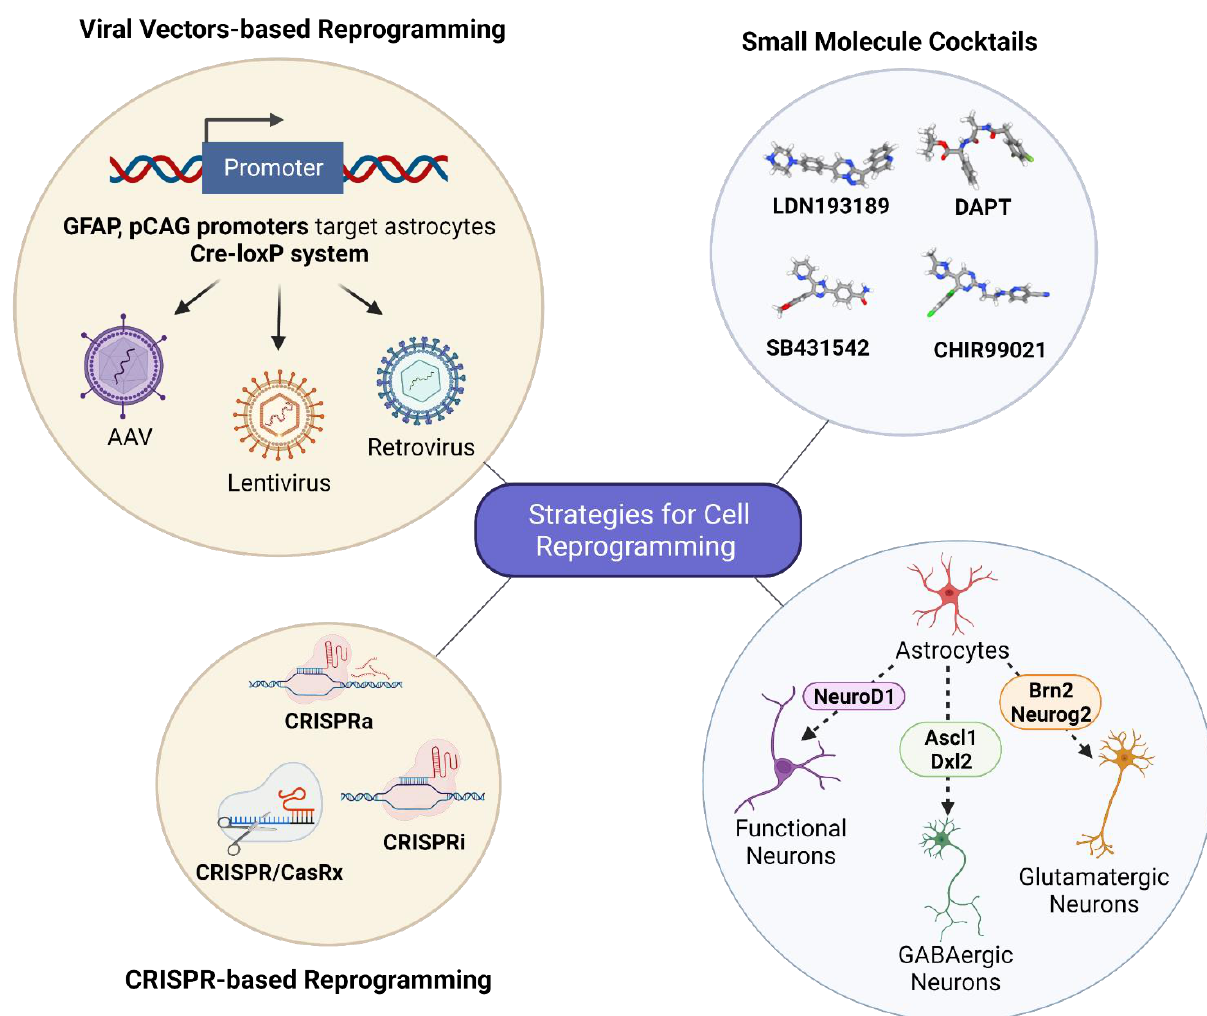
Figure 2. Current strategies to induce cell reprogramming. Methodologies used to reprogram cells in vitro and in vivo include the use of viral transduction, small molecule cocktails, or